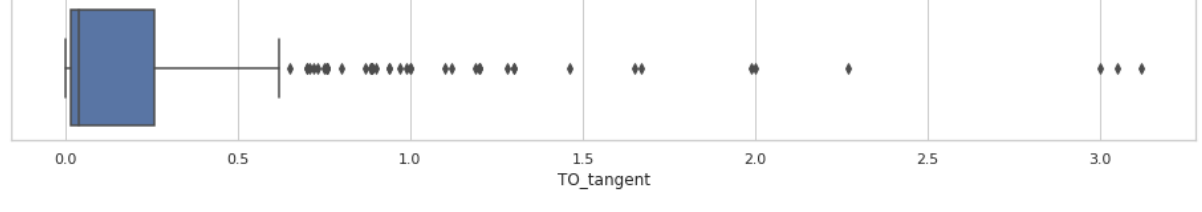
Figure 6. Distribution of the feature values before logarithmic transformation.